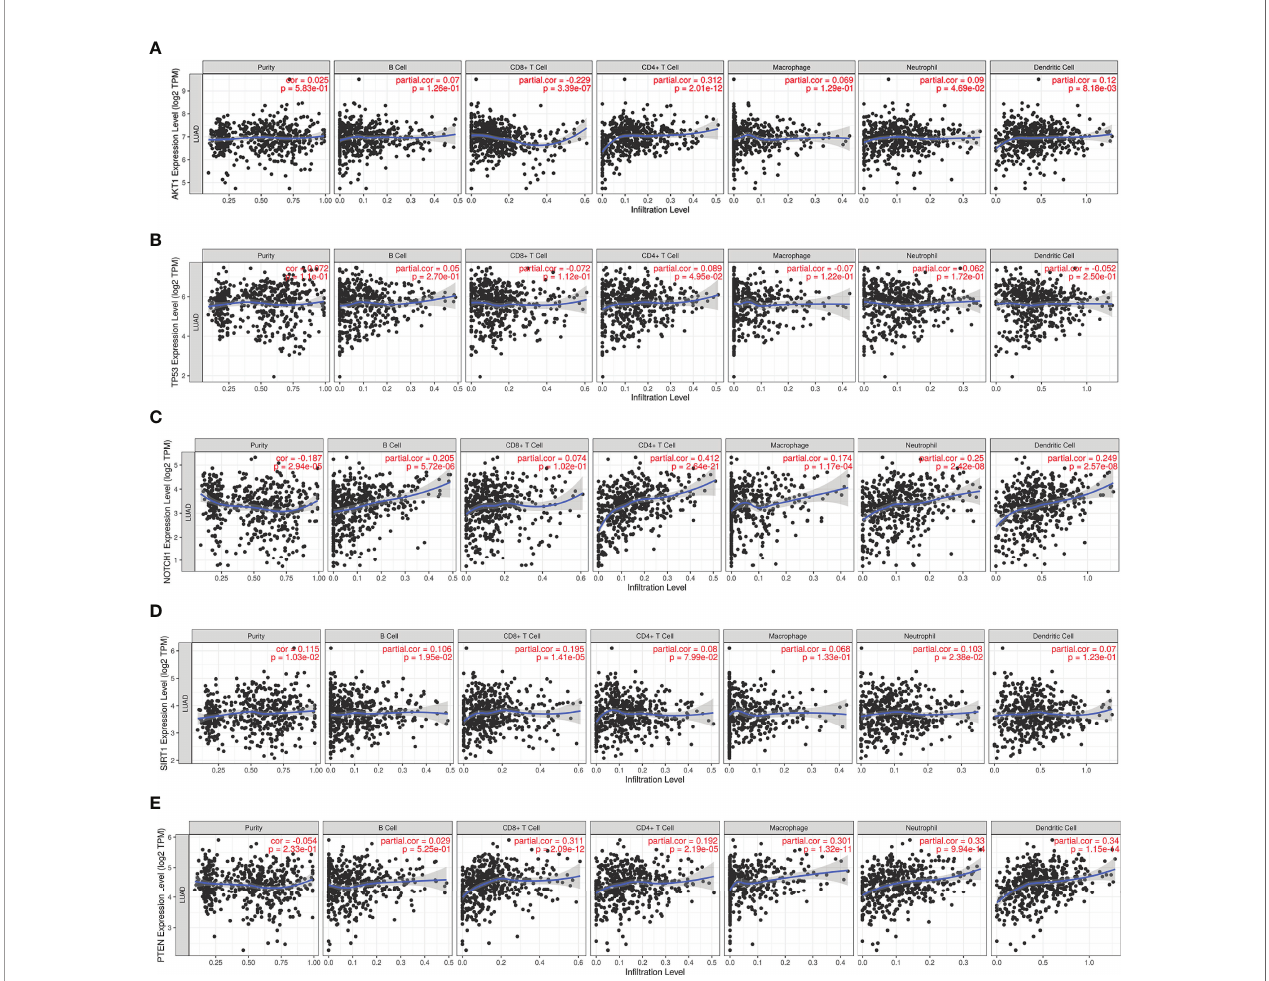
FIGURE 6 | Correlations between the 5 core target genes and immune in fi ltration level in LUAD were analyzed using TIMER database. (A) AKT1. (B) TP53. (C) NOTCH1. (D) SIRT1. (E)